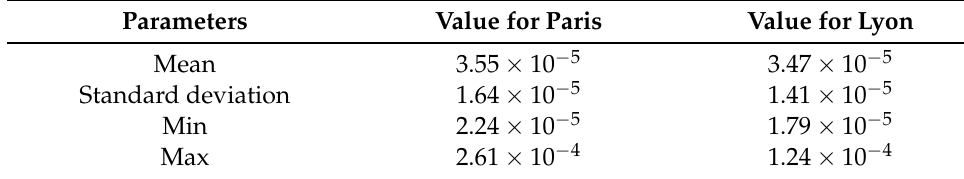
Figure 4. Maps showing the value of the logarithm of the concentration in air of CHIMERE Cd (log( µ g/m 3 ). On the left , Paris region; on the right , region of Lyon. Table 2. Main statistics of Cd concentrations ( µ g/m 3 ) modeled by